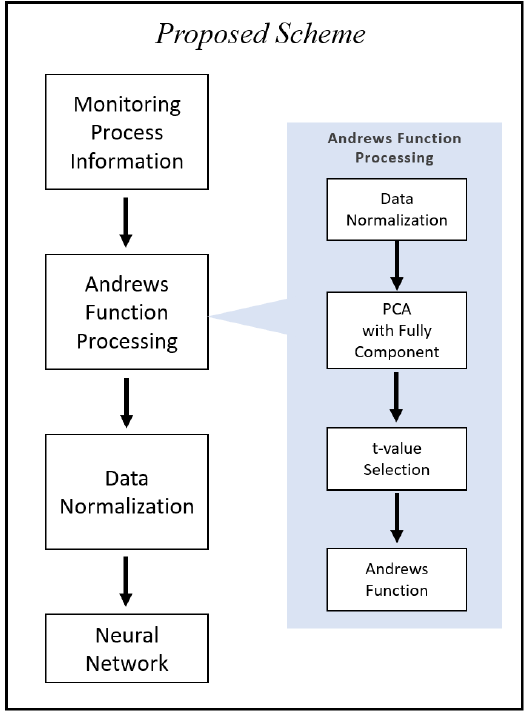
Figure 1. Framework of the proposed fault diagnosis system.